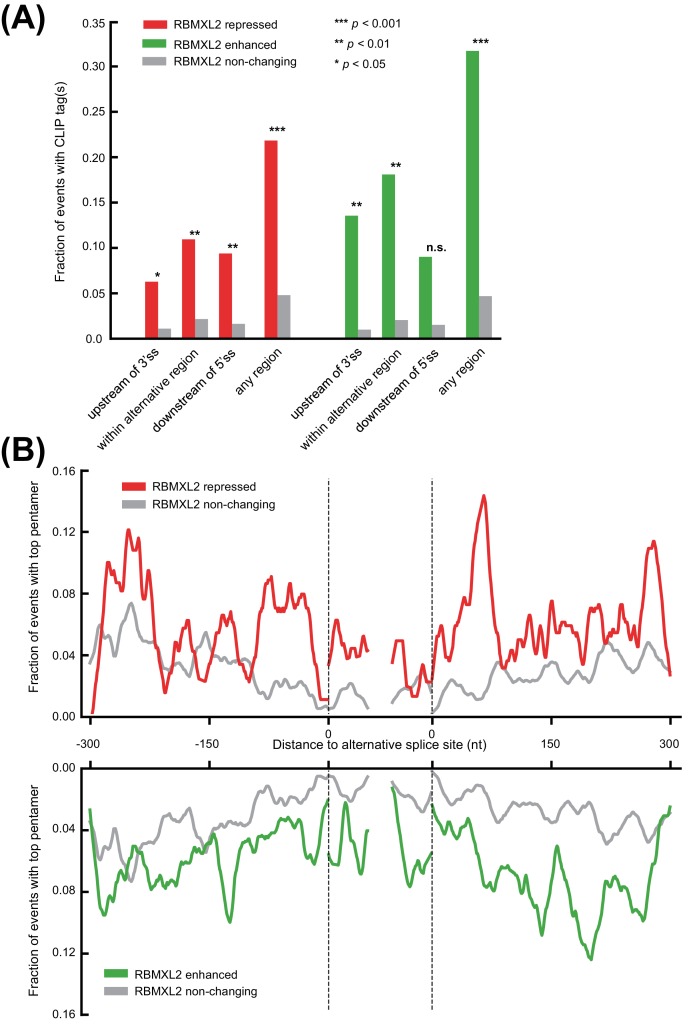
RBMXL2 CLIP and motif enrichment around regulated splicing events.(A) Barchart showing the fraction of RBMXL2 repressed events (red, n = 64); enhanced events (green, n = 22); or nonchanging events (grey, n = 192) that contain RBMXL2 HITS-CLIP tags proximal to alternatively splice regions (intronic regions within 300 nt up or downstream of a regulated junction, within the alternative exonic region, or the union of any of these regions). Significance was assessed by comparing regulated to non-changing events using a two-tailed Fisher’s exact test. (B) Motif map showing the per nucleotide frequency the top RBMXL2 HITS-CLIP defined pentamers (Figure 3D) around regulated and nonchanging events (colours as in (A)). A sliding mean of 20 nts was applied for smoothing. Dashed lines indicate the 3′ss and 5′ss with up to 50 nucleotides of the exonic regions shown.